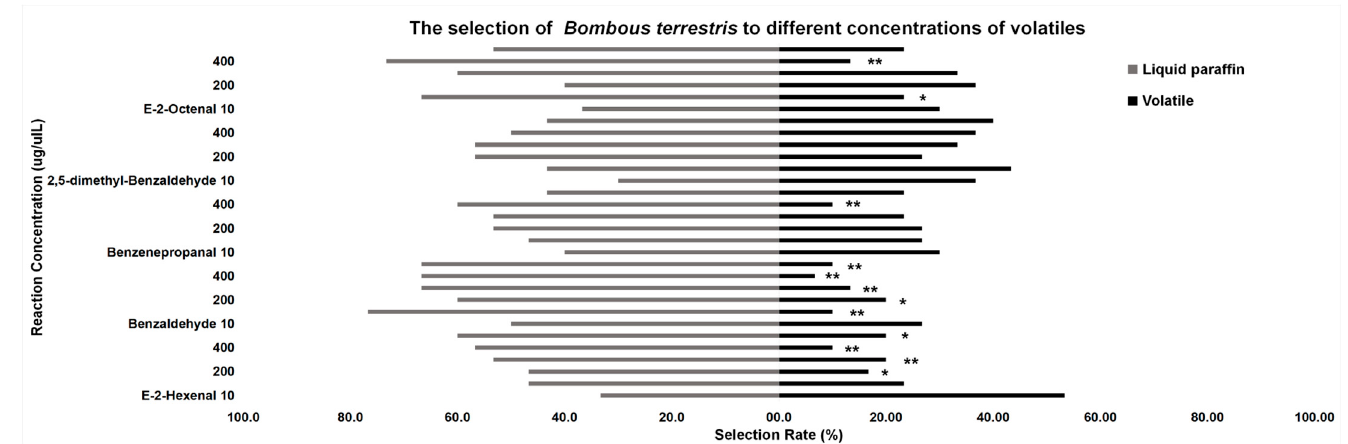
Figure 5. Behavior tests of A. mellifera. “*”means significant difference ( p < 0.05), “**” means ex- tremely significant difference ( p < 0.01). Figure 6. Behavior tests of B. terrestris . “*”means significant difference ( p < 0.05), “**” means ex- tremely significant difference ( p < 0.01).